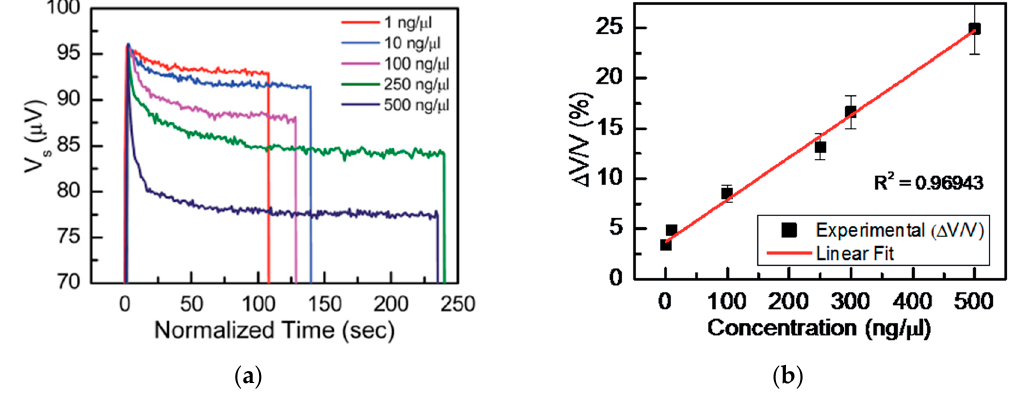
Figure 3. ( a ) Change in the sensor voltage with accumulation of superparamagnetic Nanomag-D beads on the micro-conductor with respect to the normalized time ( t assumed zero at the beginning of the measurement); ( b ) Relative change in the voltage across the GMR sensor head due to the presence of various concentrations of Nanomag-D beads on the microconductor (MC) (Reproduced with permission from [36]. The Royal Society of Chemistry, 2015.).